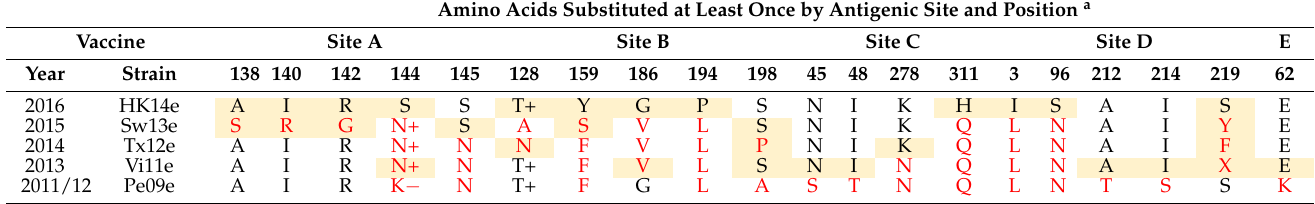
a: Amino acids that differ from the prior vaccine strain are shaded yellow, while those that differ from the prevailing 2016 vaccine strain are colored red; + indicates introduction of a potential glycosylation site.